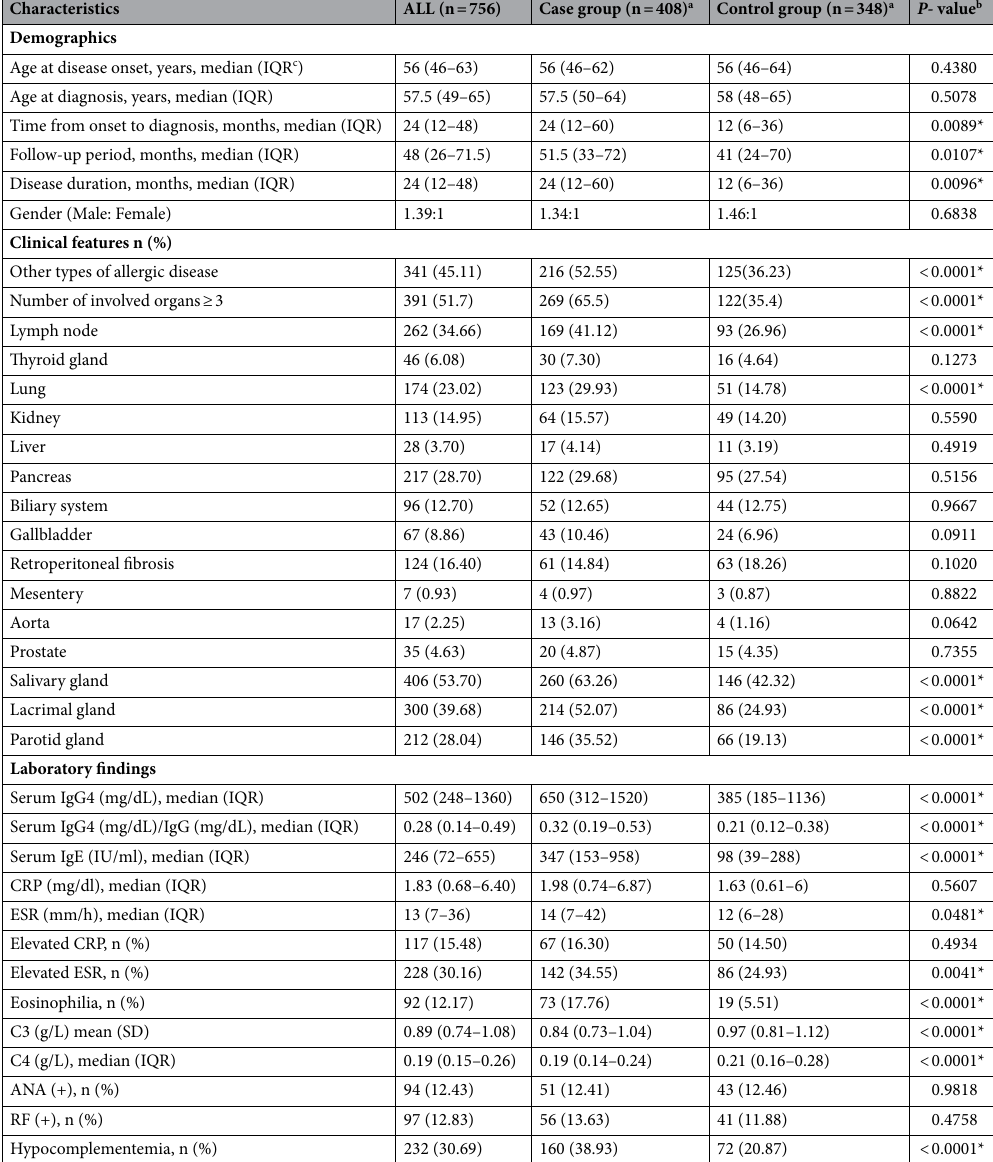
Table 2. Differences of demographic, clinical and laboratory characteristics between IgG4-RD patients complicated with AR/CRS (case group) and without AR/CRS (control group). a Case group included IgG4-RD patients complicated with AR or CRS, and the control group included IgG4-RD patients without AR or CRS; b *means P -value < 0.05; c IQR, interquartile